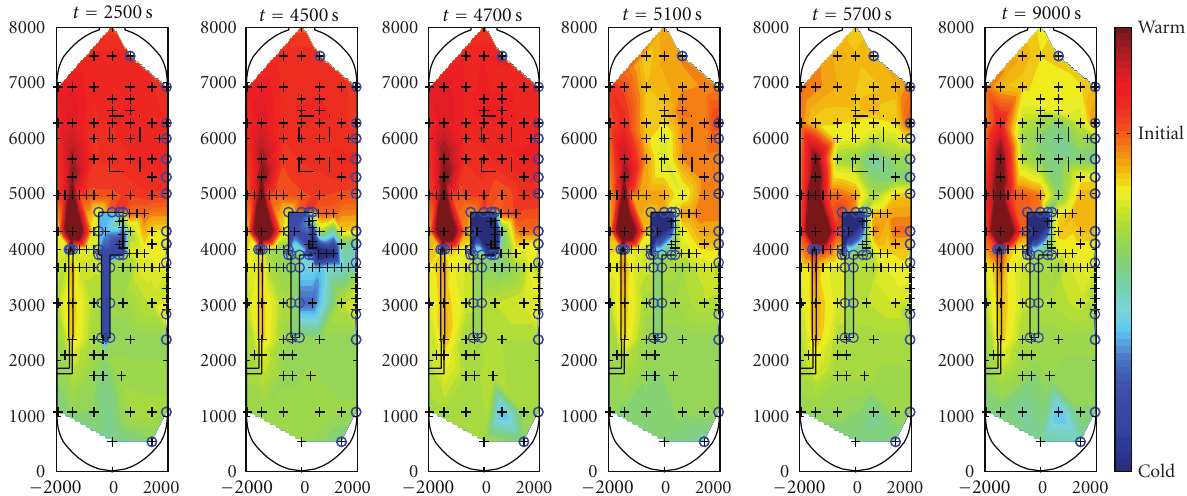
Figure 9: Temperature contour maps in Vessel 1 for experiment ST4 2 2 for di ff erent instances in time.